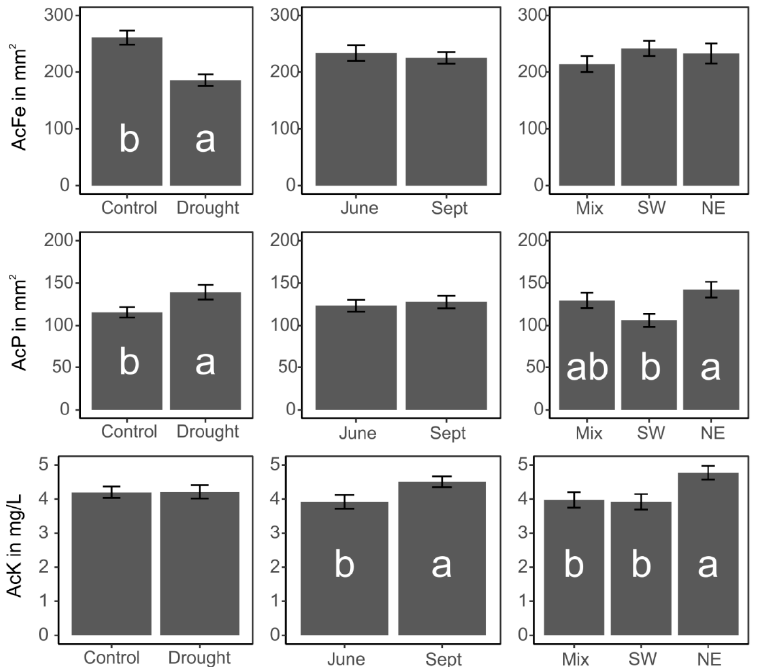
Figure 3. Mean ± standard error biological activities of the isolated Pseudomonas strains. Influence of treatment (C, control; D, drought), plant community composition (SW, Southwest European plant species; NE, Northeast European plant species; Mix, SW and NE plant species) and season (June and Sept, September) on potassium (AcK) and phosphate (AcP) solubilization, as well as siderophore (AcFe) production activities of the Pseudomonas strains. Significant differences ( p <0.05) according to ANOVA and Tukey’s HSD test are indicated by different letters.